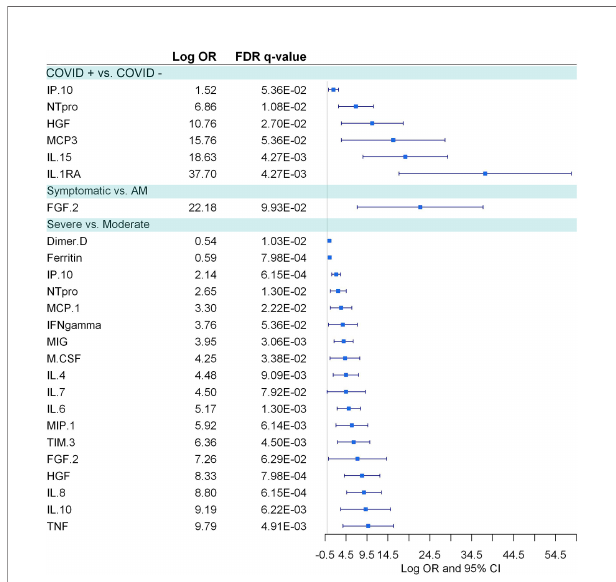
FIGURE 7 | Pairwise group comparisons of cytokines. Logistic regression, adjusted for age and sex, was used. The False Discovery Rate or FDR was used to cope with multiple testing, q-values are provided.